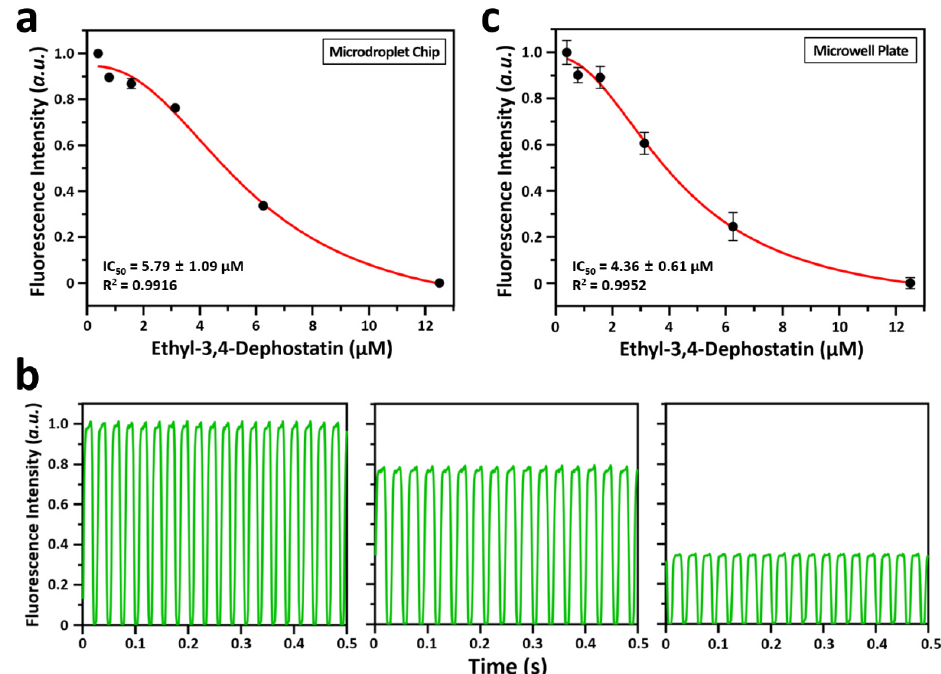
Figure 4. Fluorescence intensity analysis at a fixed concentration of 3-OMFP, DUSP22, and at designated concentrations of ethyl-3,4-dephostatin. ( a ) Analysis of inhibition of DUSP22 activity in a microdroplet chip. The concentrations of DUSP22 and 3-OMFP were fixed at 100 nM and 10 µM, respectively, and the concentration of ethyl-3,4-dephostatin was varied (0.39, 0.78, 1.56, 3.13, 6.25, and 12.5 µM). Some error bars not shown are smaller than the black circle of each concentration. ( b ) Examples of fluorescence intensity scanned for 0.5 s from ~340.4 pL droplets generated within a microdroplet chip. From the left, the concentrations of ethyl-3,4-dephostatin are 0.39, 3.13, and 6.25 µM, respectively. ( c ) Analysis of inhibition of DUSP22 activity in a microwell plate. The concentrations of DUSP22 and 3-OMFP were fixed at 100 nM and 10 μ M, respectively, and the concentration of ethyl-3,4-dephostatin was varied (0.39, 0.78, 1.56, 3.13, 6.25, and 12.5 µM).